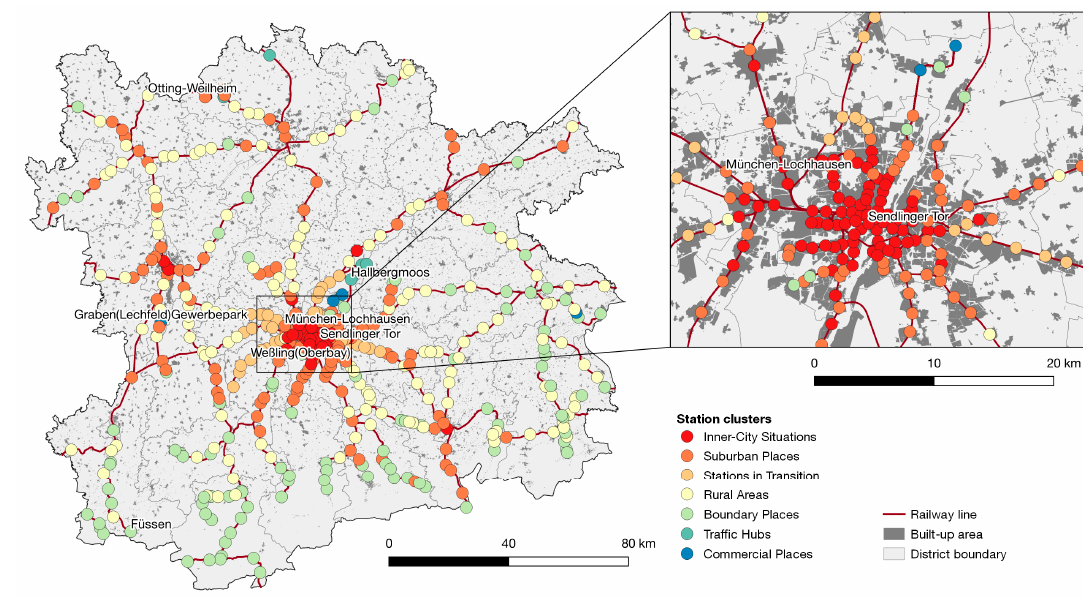
Figure 9. Spatial distribution of the station clusters (Source: own work, using geodata by Bayerische Vermessungsverwaltung, Bundesamt für Kartographie und Geodäsie, Deutsche Bahn). Table 2. Average values of the clustering variables for the seven clusters of stations.